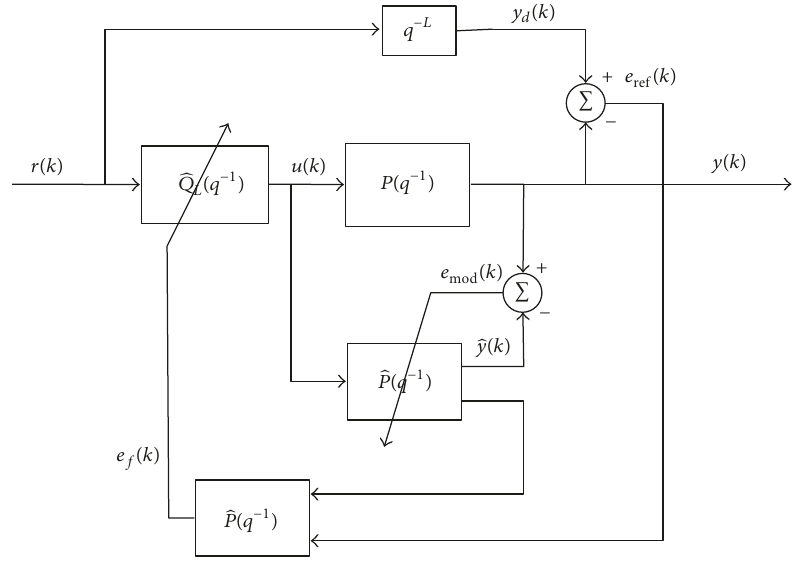
Figure 4: Direct adaptive inverse control